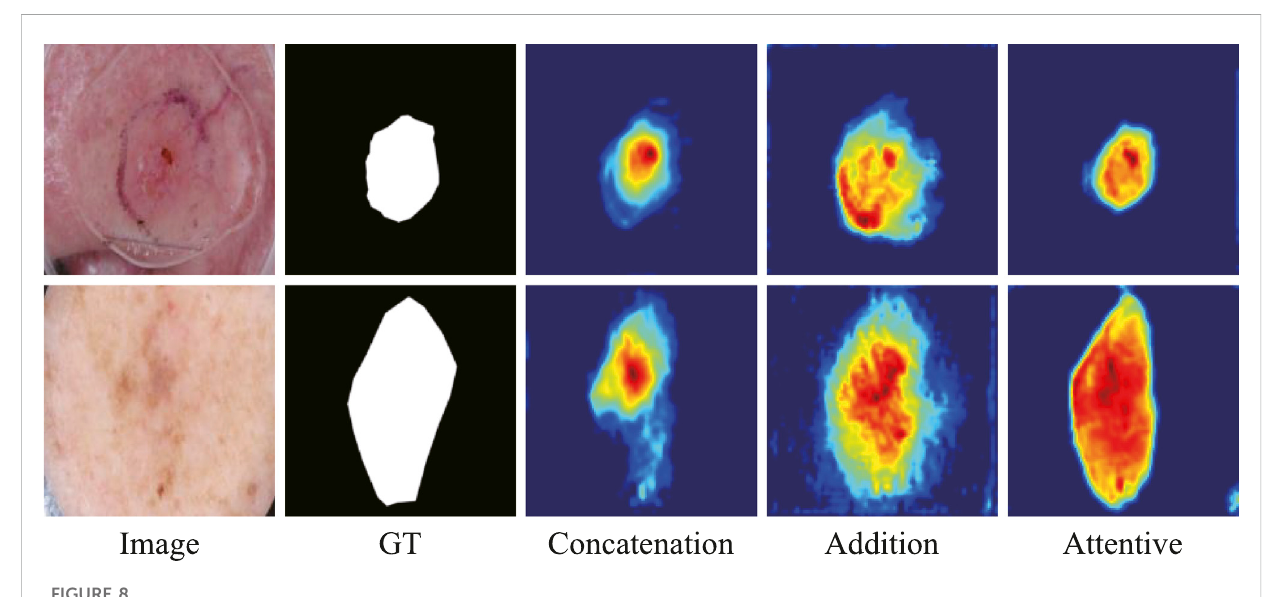
FIGURE 8 Features from the ablation study on the fusion methods in